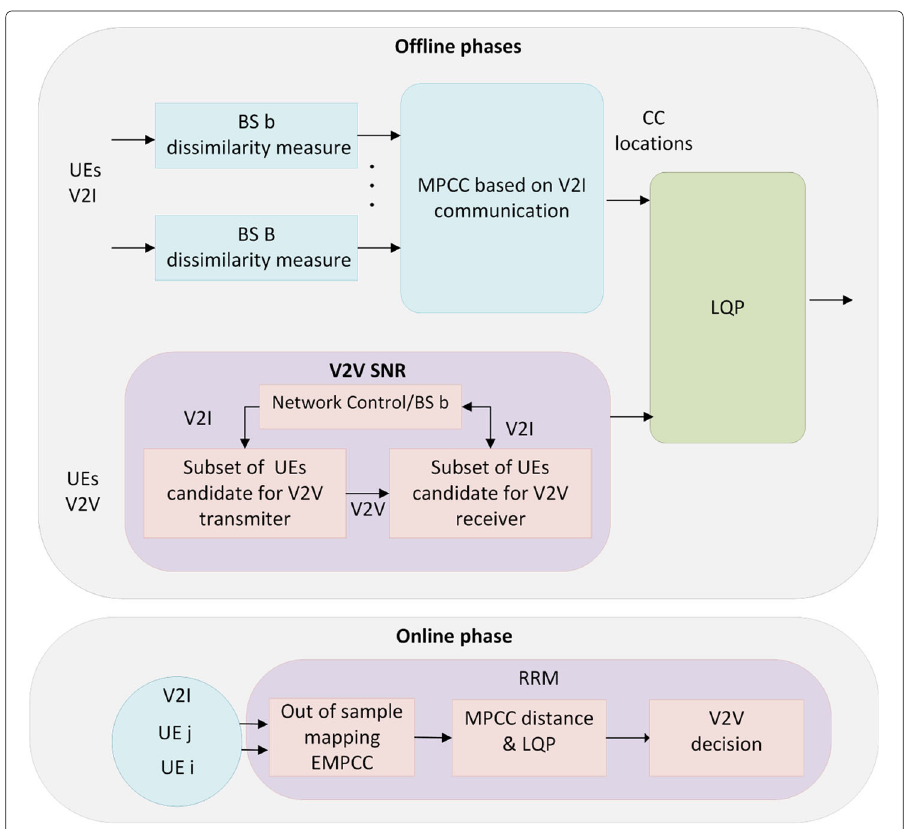
Fig. 4 RRM for V2I/V2V communication systems. Offline phase: the MPCC and LQP models are constructed. Online phase: network management uses EMPC and LQP to predict V2V connectivity